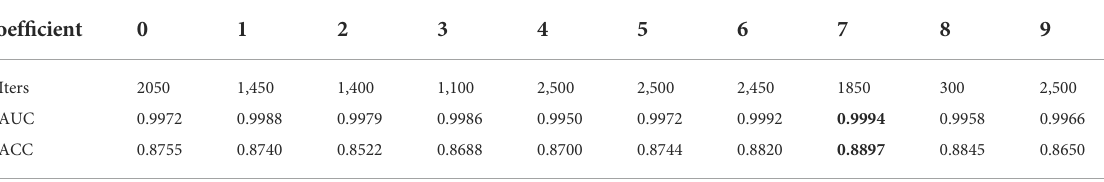
TABLE 4 Experiments of MS and normalization.